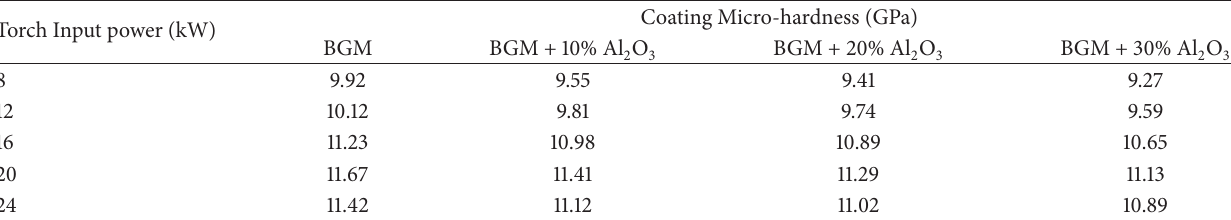
Figure 4: Variation of coating adhesion strength with plasma torch input power. Table 5: Variation of micro-hardness with torch input